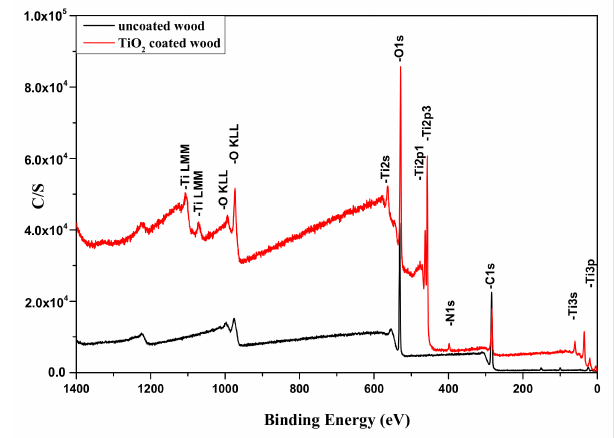
Figure 6. Survey spectra for uncoated (black) and TiO 2 -coated wood (red) showing oxygen peaks and a carbon peaks and titanium peak.